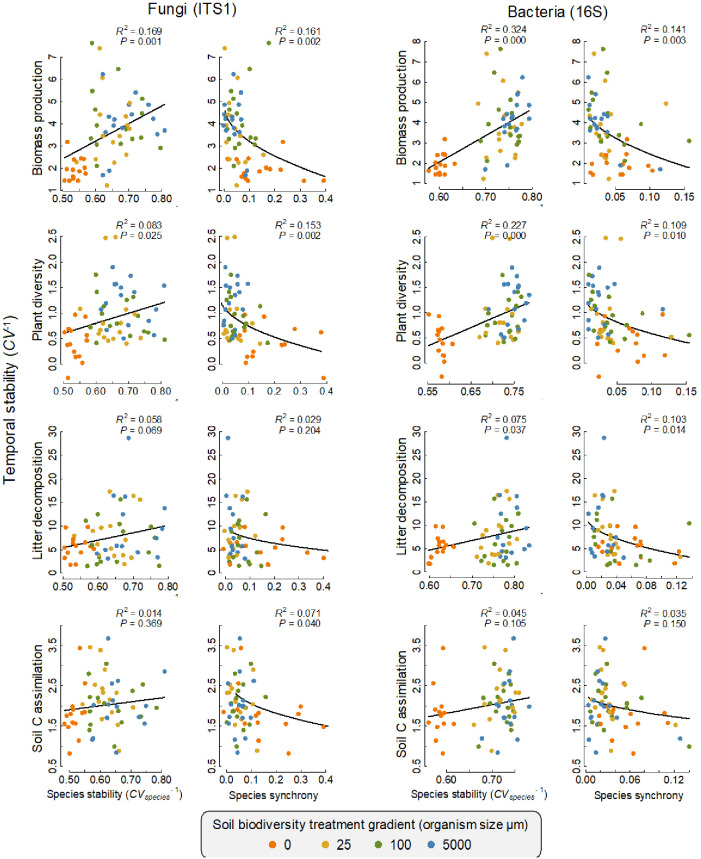
Temporal stability in ecosystem functions relationships with the temporal stability and synchrony in the abundance of individual fungal and bacterial taxa.Species stability (CVspecies−1) and synchrony were calculated using the abundance of operational taxonomic units (OTUs) that were found to have an impact on the function. Solid lines highlight the relationship and the fit (R2) and significance (p) statistics are provided for each panel.